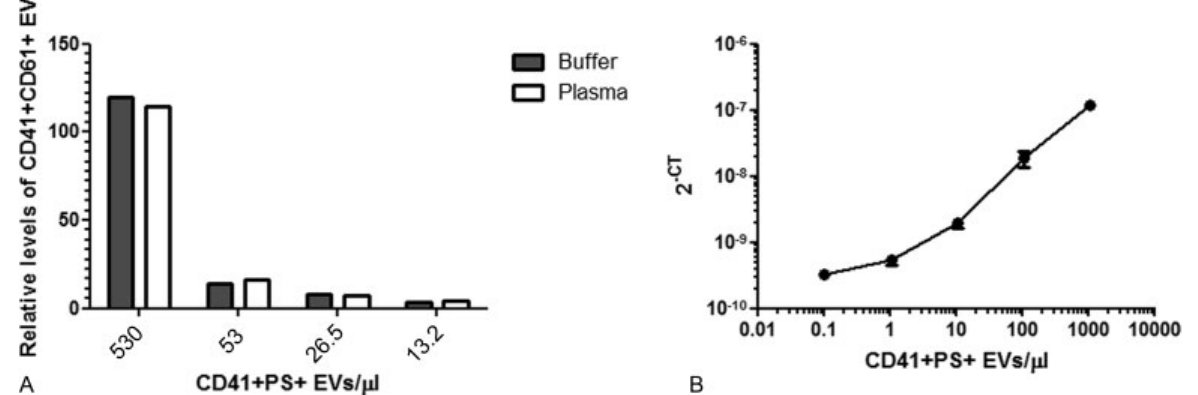
Fig. 4 Detection of spiked platelet-derived EVs. ( A ) Platelet EVs were counted by fl ow cytometry (Navios, Beckman Coulter) and spiked at different concentrations either in PLA buffer or in EV-free plasma (diluted 1/100). The PLA signals relative to background (only buffer) after lactadherin capture and CD41/CD61 detection from a representative experiment ( n ¼ 1) is shown. ( B ) To determine the LOD score, washed platelet-derived EVs were counted by fl ow cytometry (Navios). The EVs were then spiked in PLA buffer to create a dilution series (1:10) and